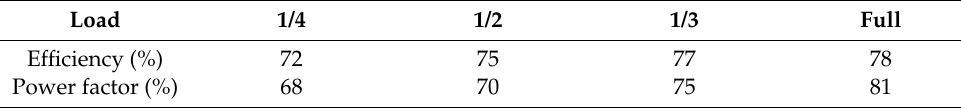
Table 4. Efficiency and power factor for pump motor.